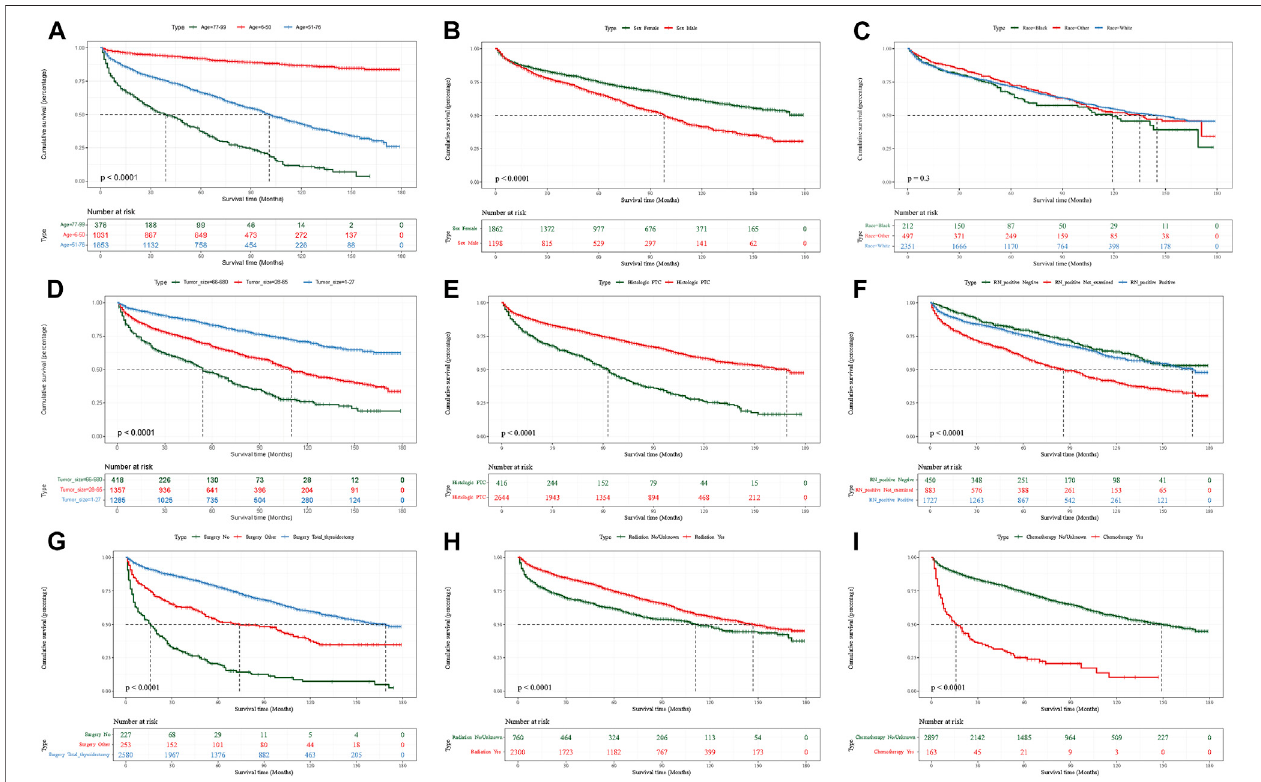
FIGURE 2 | Kaplan – Meier survival curves to evaluate the impact of each classi fi ed